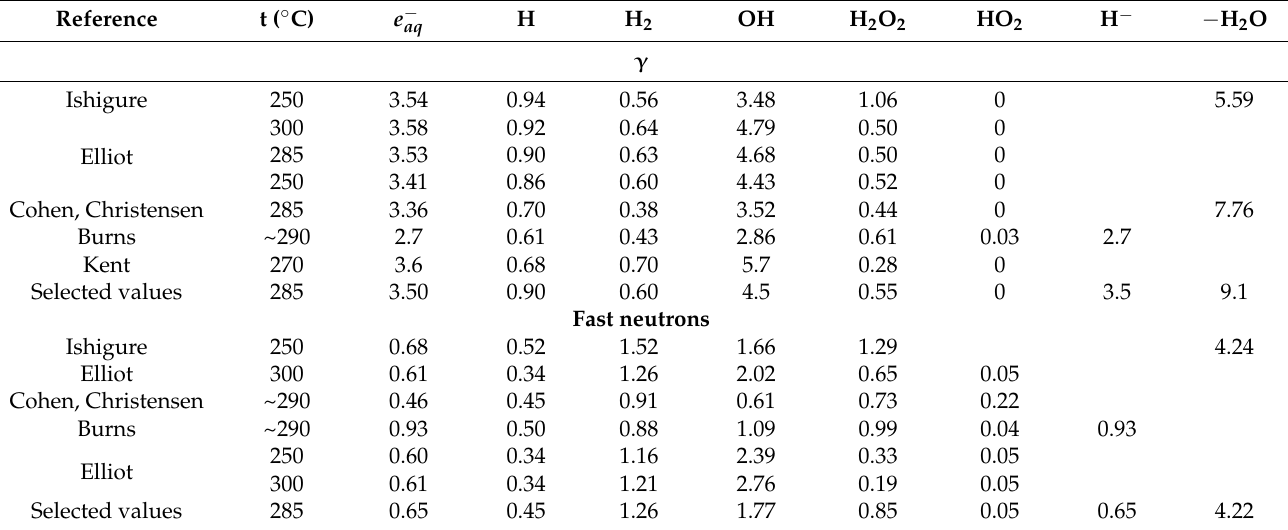
Table 16. Summary of primary (?) * radiolytic yields employed by Christensen et al. [28] in modeling radiolysis in the INCA loop.